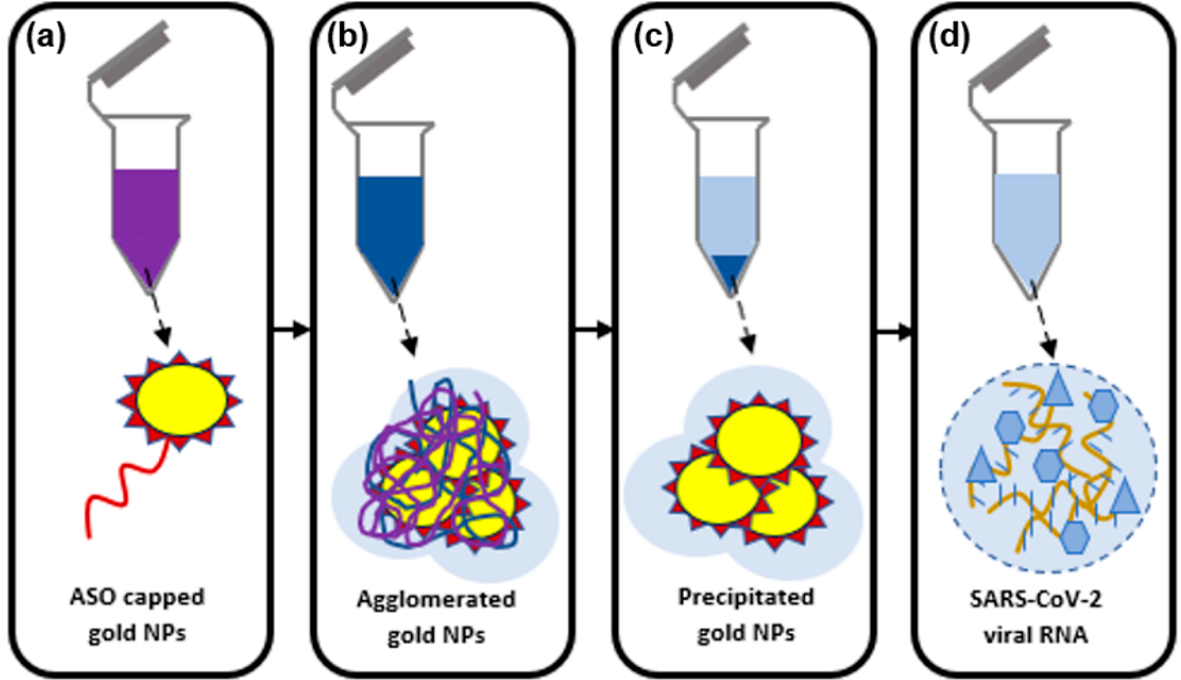
Figure 6. Schematic diagram of ( a ) ASO-capped AuNPs targeted for N-gene of SARS-CoV-2, ( b ) agglomerated AuNPs in the presence of the virus RNA, ( c ) selective positive detection of SARS- CoV-2 with the visual naked-eye, and ( d ) extracted SARS-CoV-2 viral RNA.